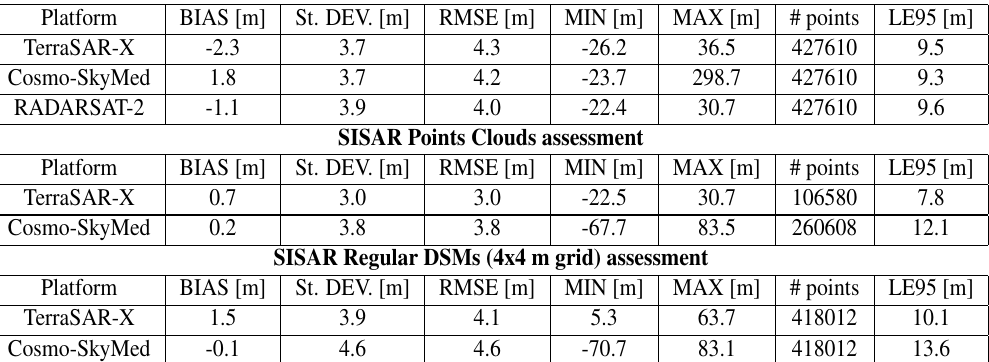
Table 3: Beauport overlap area - CSK, TSX, R2 DSMs accuracy